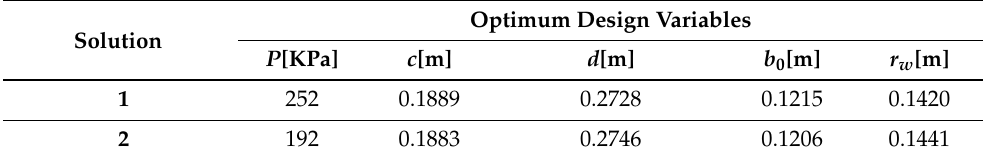
Figure 10. The tread profile induced to the tyre for the two common optimal tyre designs, after the vehicle is driven over the Class B S-path 20 times back and forth. Table 5. Optimal tyre design variables of the identified common solutions among the two cases of different road profiles.